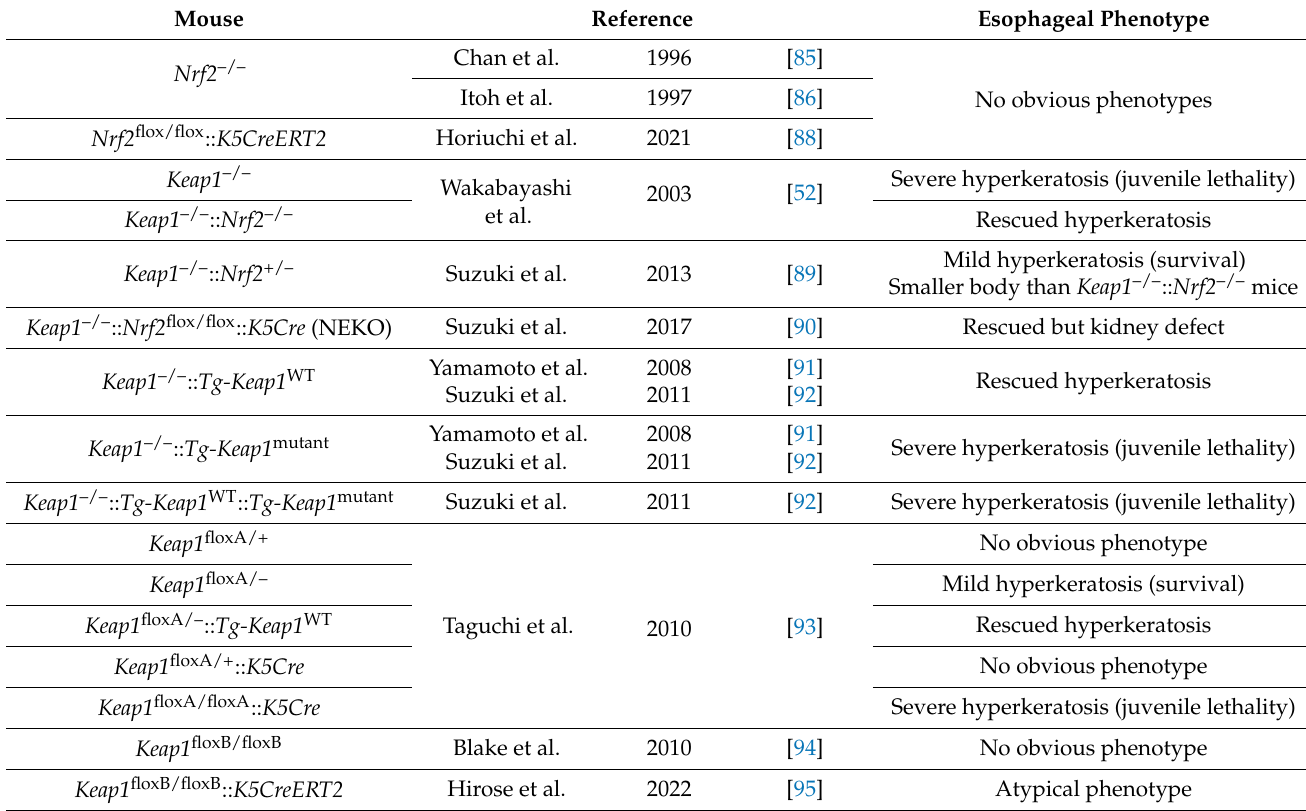
Table 2. Esophageal phenotypes of genetically modified mouse models targeting Nrf2 and Keap1